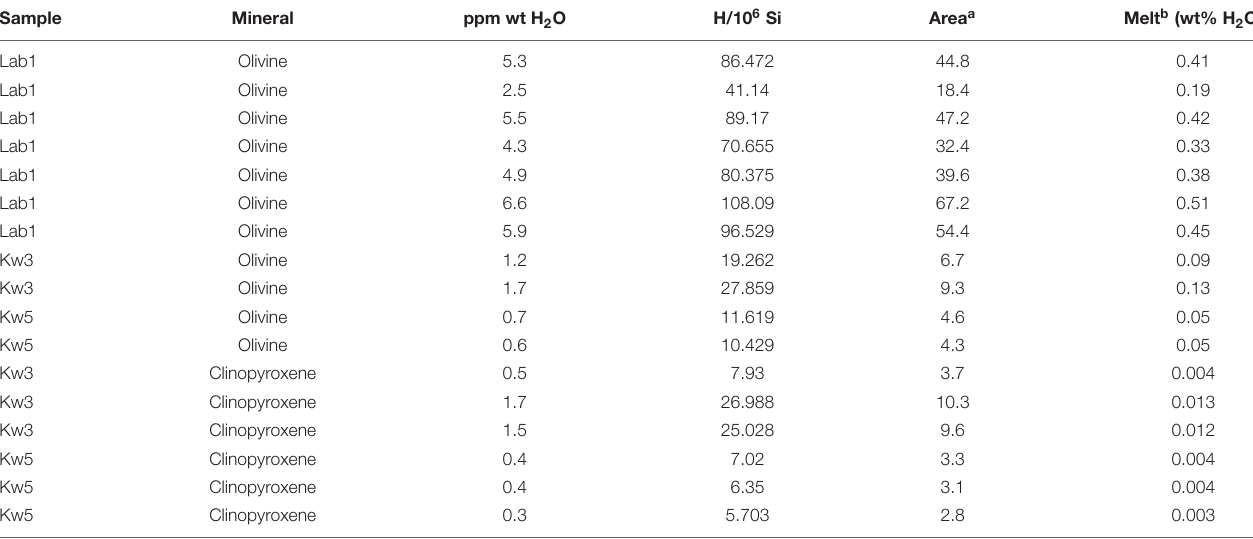
TABLE 4 | Water contents in olivine and cpx, and those calculated for their associated parental